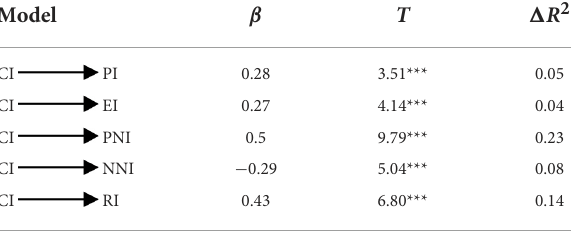
TABLE 7 The results of the